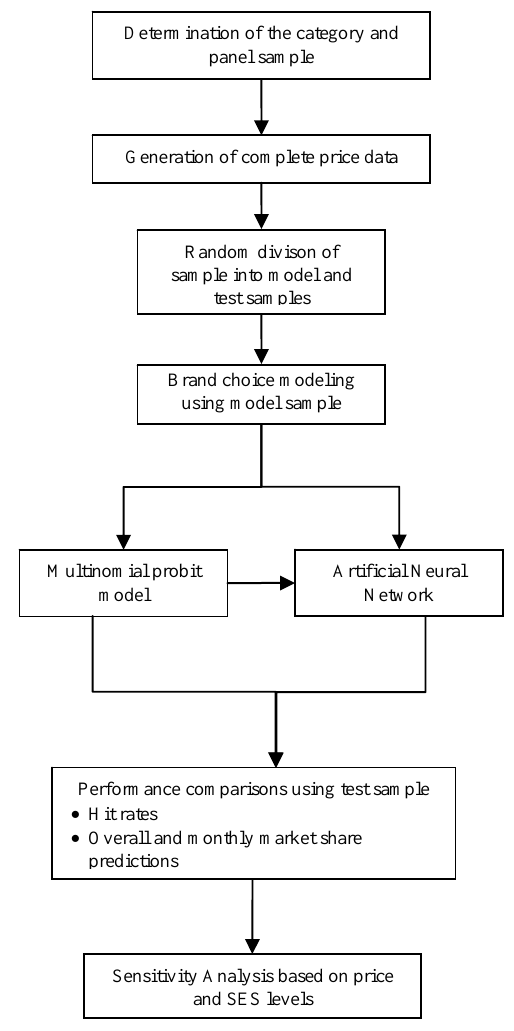
Figure 1 Framework of the proposed